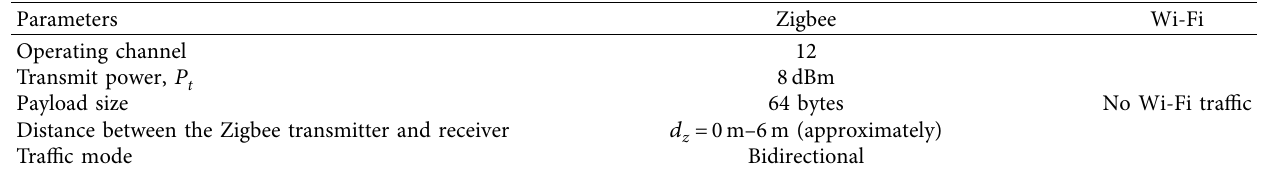
Table 7: Parameters for the experiments in Section 4.2.3 (1)